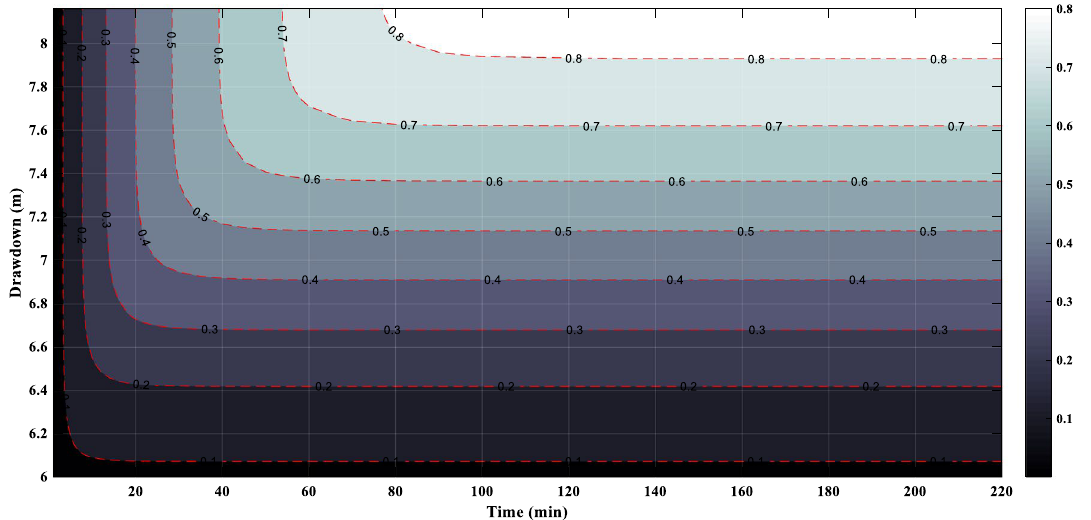
Fig. 8 Contour lines with a cumulative probability of groundwater drawdown and pumping time for pumping test with a discharge of 26.64 l/s